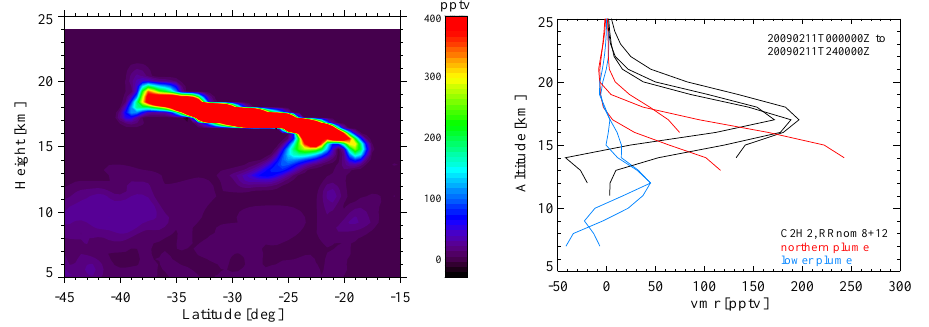
Fig. 11. Left: latitudinal cross section through the model plume of 11 February at 172 ◦ W in original resolution. Right: C 2 H 2 profiles measured on 11 February 2009, inside the southern (black) and northern part of the plume (red), and in weaker parts of the lower plume (blue).